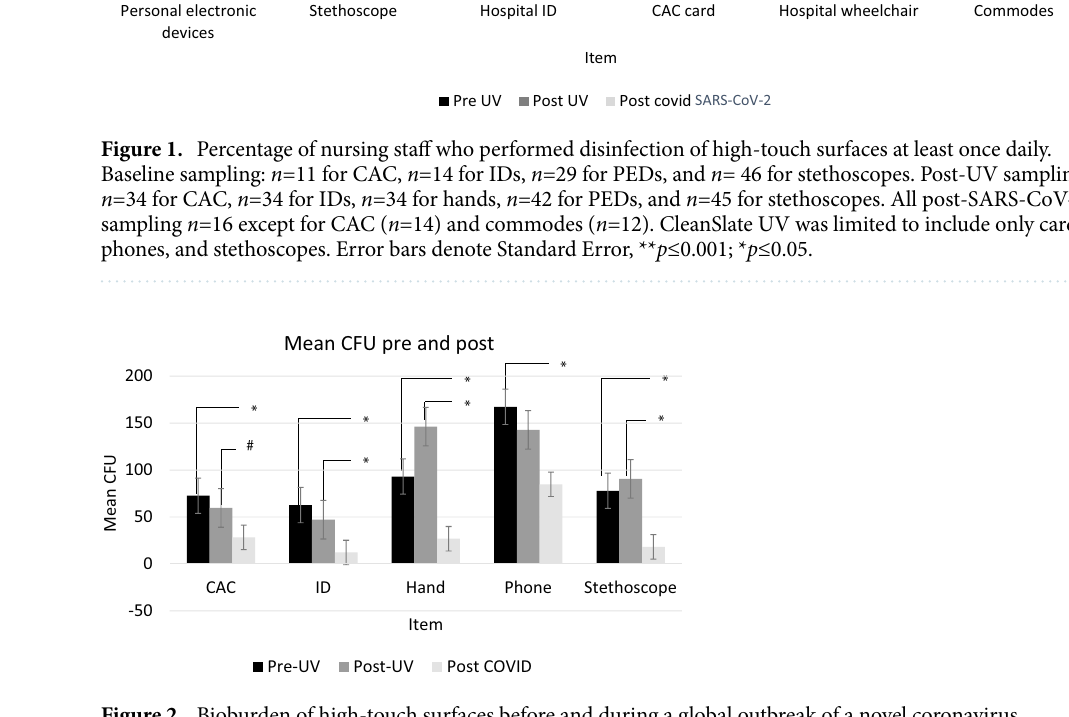
Figure 2. Bioburden of high-touch surfaces before and during a global outbreak of a novel coronavirus (SARS-CoV-2). Baseline sampling: n =59 for CAC, n =59 for IDs, n =31 for hands, n =60 for phones, and n = 43 for stethoscopes. Post-intervention sampling: n =57 for CAC, n =57 for IDs, n =34 for hands, n =56 for phones, and n =30 for stethoscopes. All post-outbreak sampling n =23 except for stethoscopes ( n =20). Error bars denote Standard Error, * p ≤0.001; # p